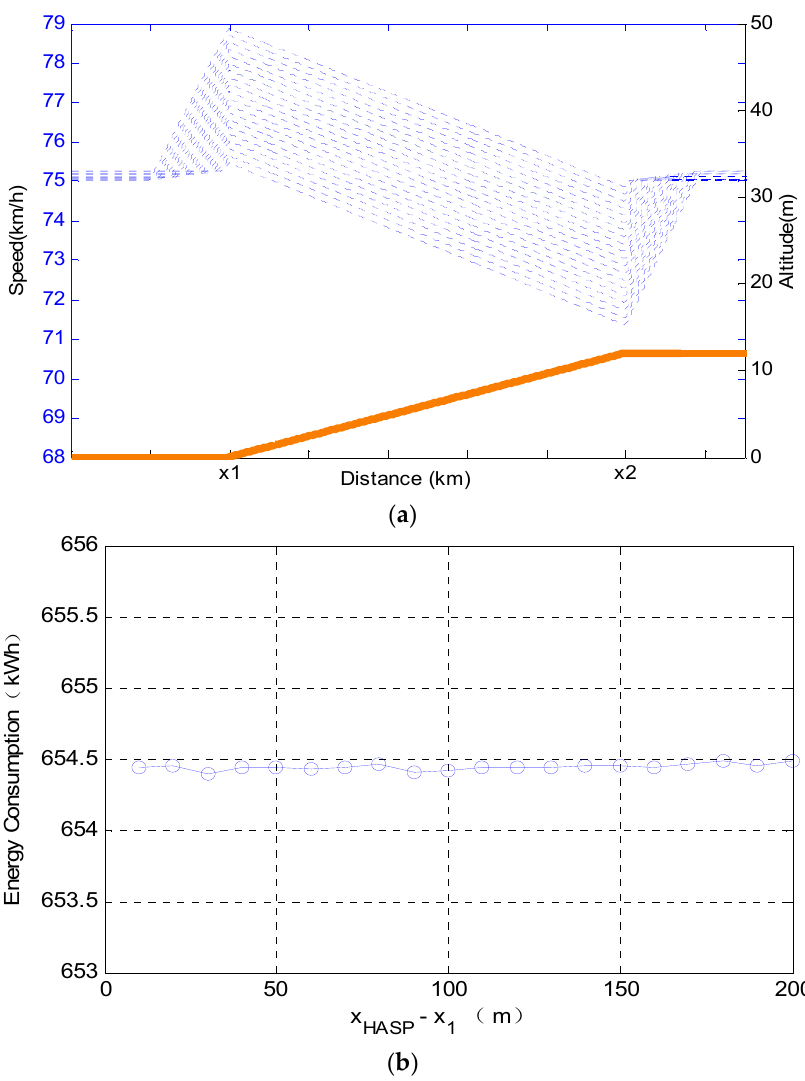
Figure 14. Comparison chart of different steep-uphill-pass strategies for a 1 km uphill slope. ( a ) Speed profiles of different strategies; ( b ) Energy consumptions of different strategies in ( a ).